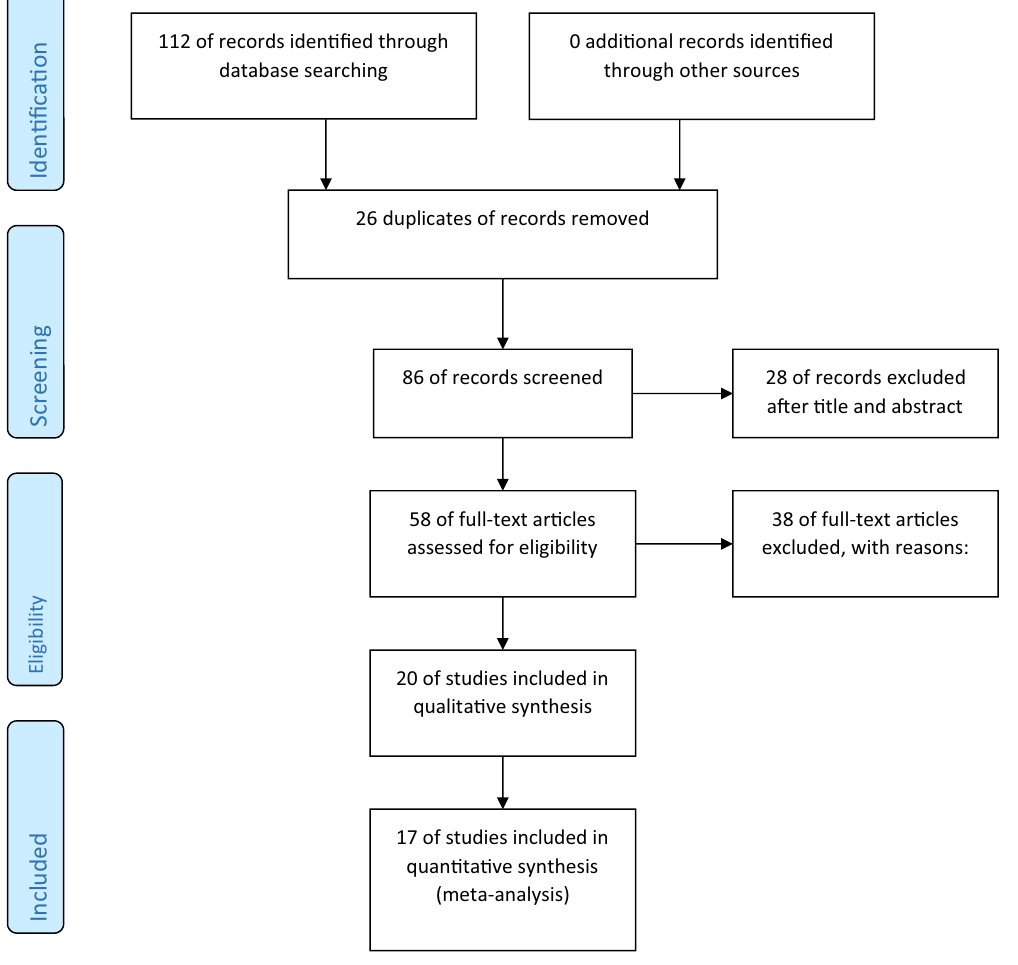
Figure 7. Flow of information through the stages of the